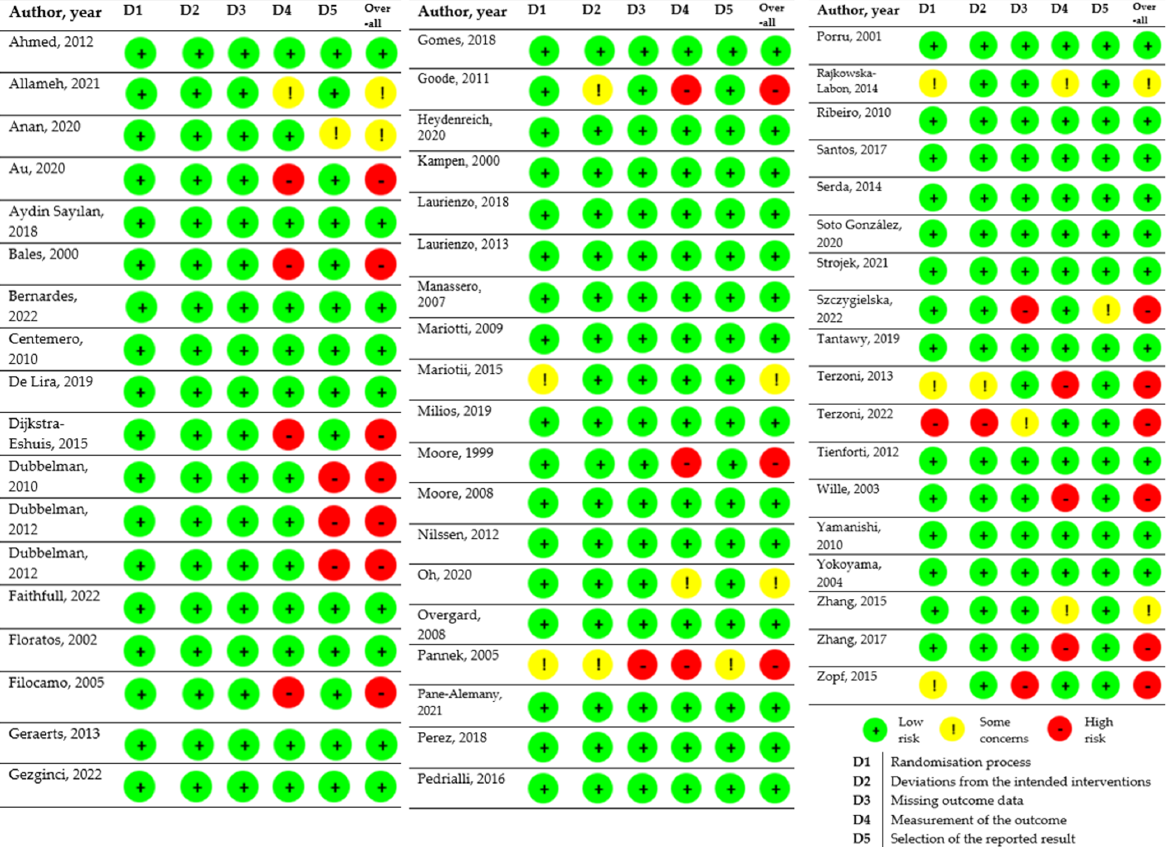
Figure A1. RoB analysis ( n = 55). Low risk studies: [16,19–33,35–37,39–43,45–53], some concerns studies: [17,18,34,38,44,54], high risk studies [62,72–86].